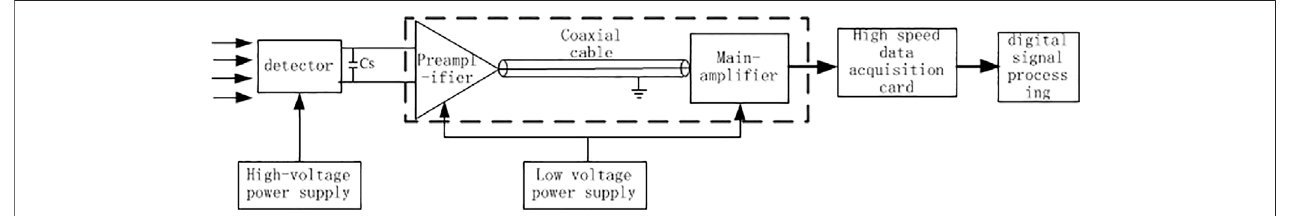
FIGURE 7 | Structural block diagram of the neutron measurement